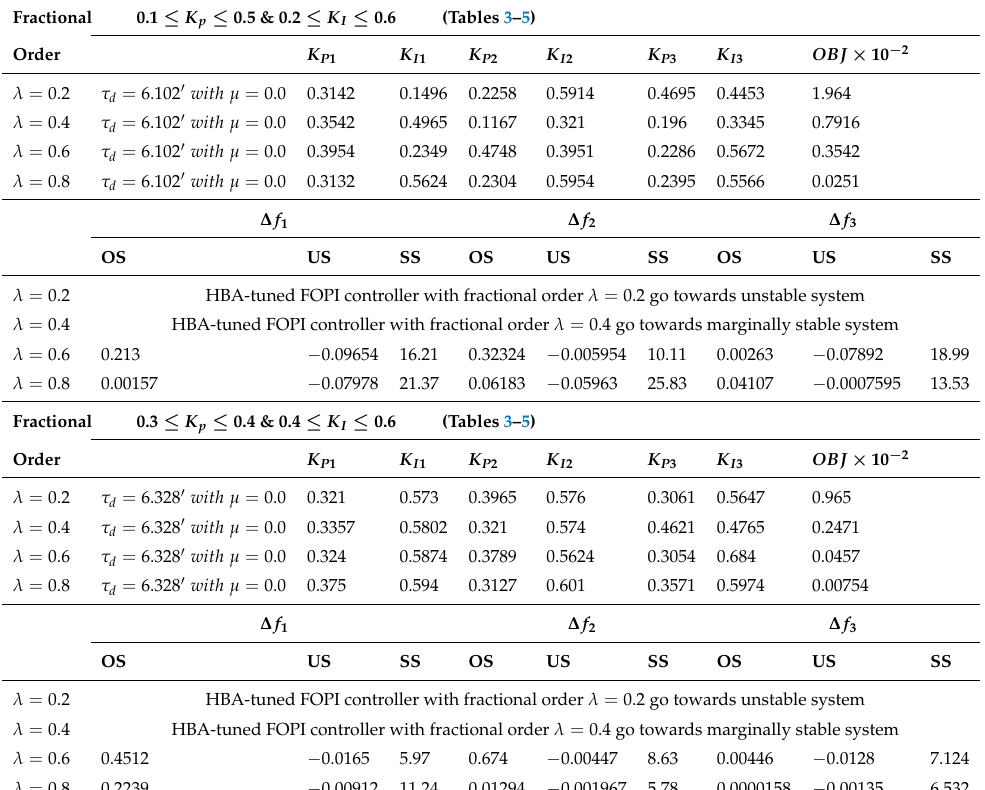
Table 6. Gain values of FOPI controllers for thermal-solar-wind system (test system 2) with DGS under deregulated environment in unilateral condition with time